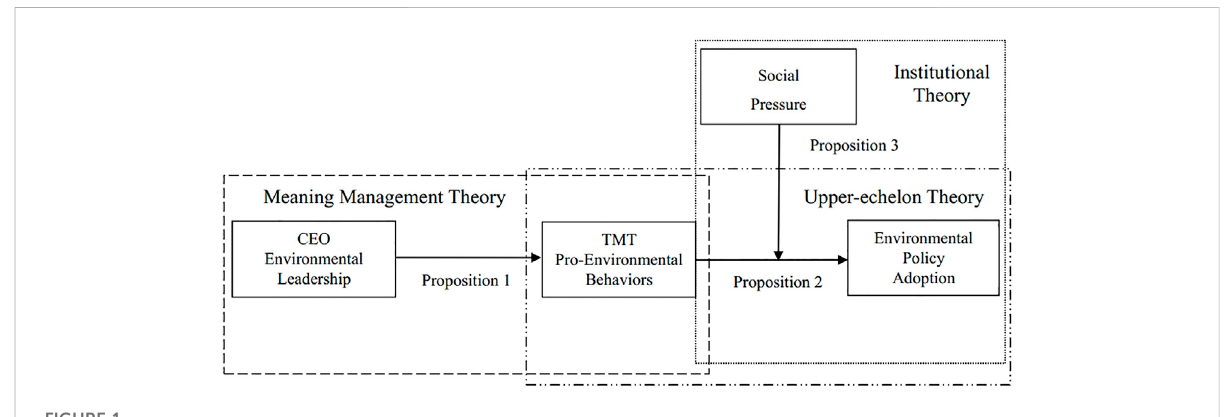
Research model of this